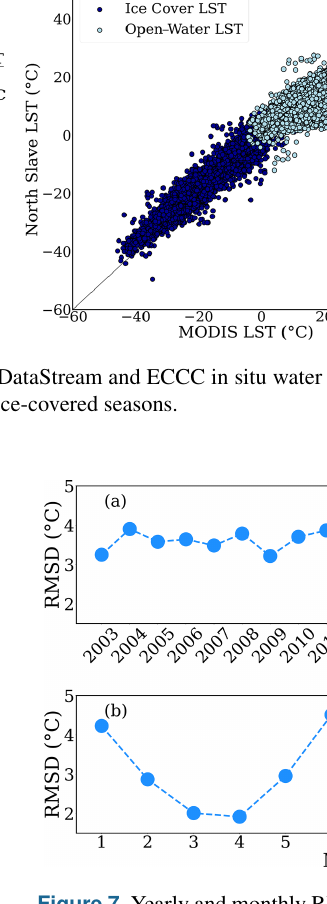
Figure 7. Yearly and monthly RMSD values from evaluating North Slave LST with MODIS LST from 2003 to